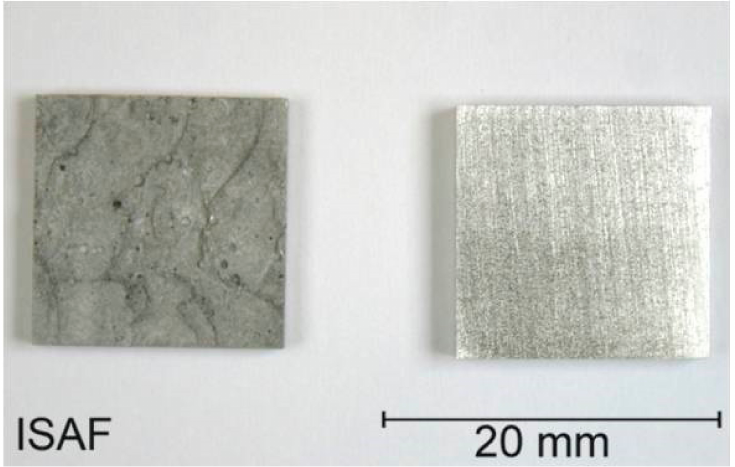
Figure 13. Corrosion samples after 2 h exposure (left: single layer, right: single layer